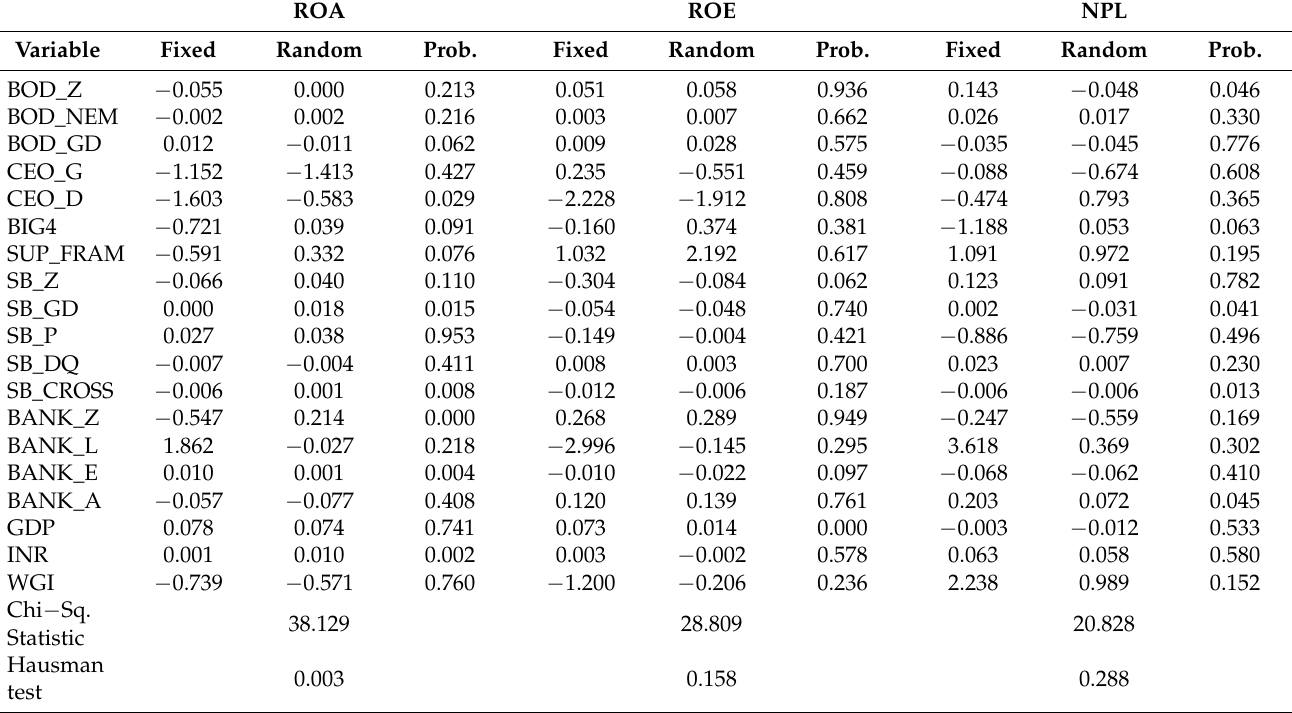
Table A5. Hausman test—Islamic